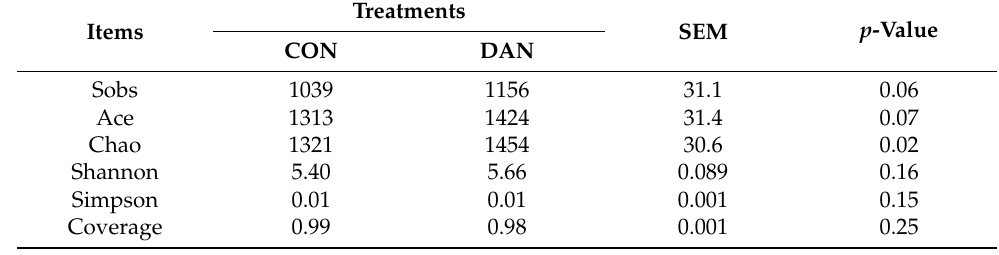
Figure 1. The rank-abundance curves are derived from the microbial OTU level, the Venn graph illustrating overlap of microbial OTUs among treatments at the 3% dissimilarity level ( A ). PCoA analysis of taxonomical classifications in the cows fed control (CON) and dandelion (DAN) diets ( B ).